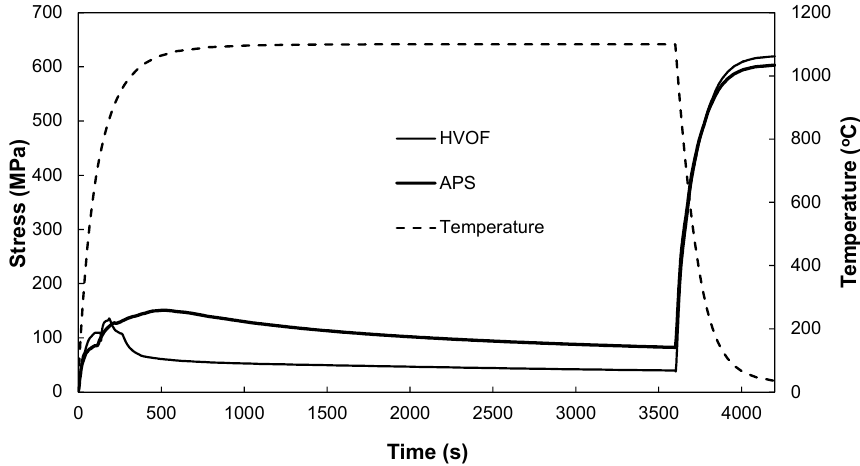
Figure 13. Comparison of equivalent stress of TBC with a bond coat made using APS and HVOF.